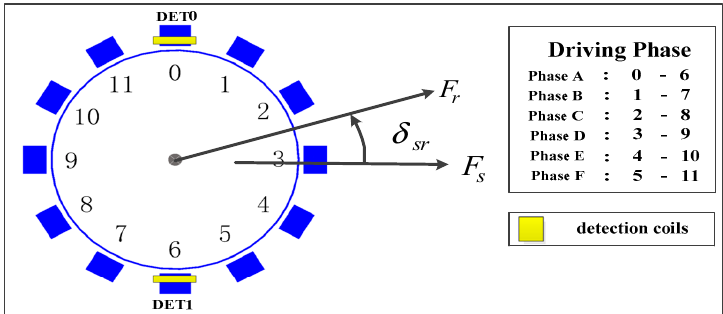
Figure 5. Driving schematic diagram.